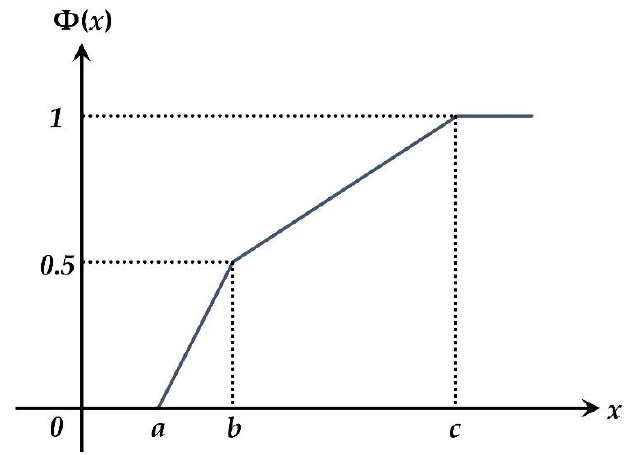
Figure 1. Zigzag uncertainty distribution Z ( a,b,c ).